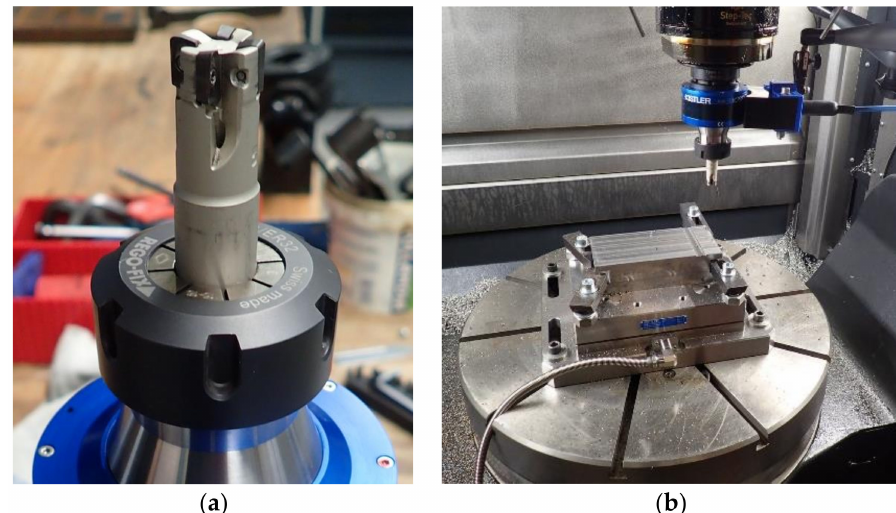
Figure 10. The cutting tool used for the machine-to-machine validation: ( a ) HP E90AN-D16-4-C16- 07-C end mill body with HP ANKT 070208PNTR insert; ( b ) machining setup on the MCU 700 machine tool.